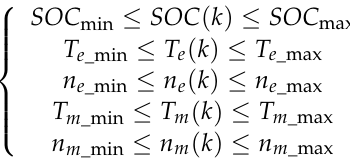
Figure 17. Schematic diagram of state feasible domain at each prediction horizon.